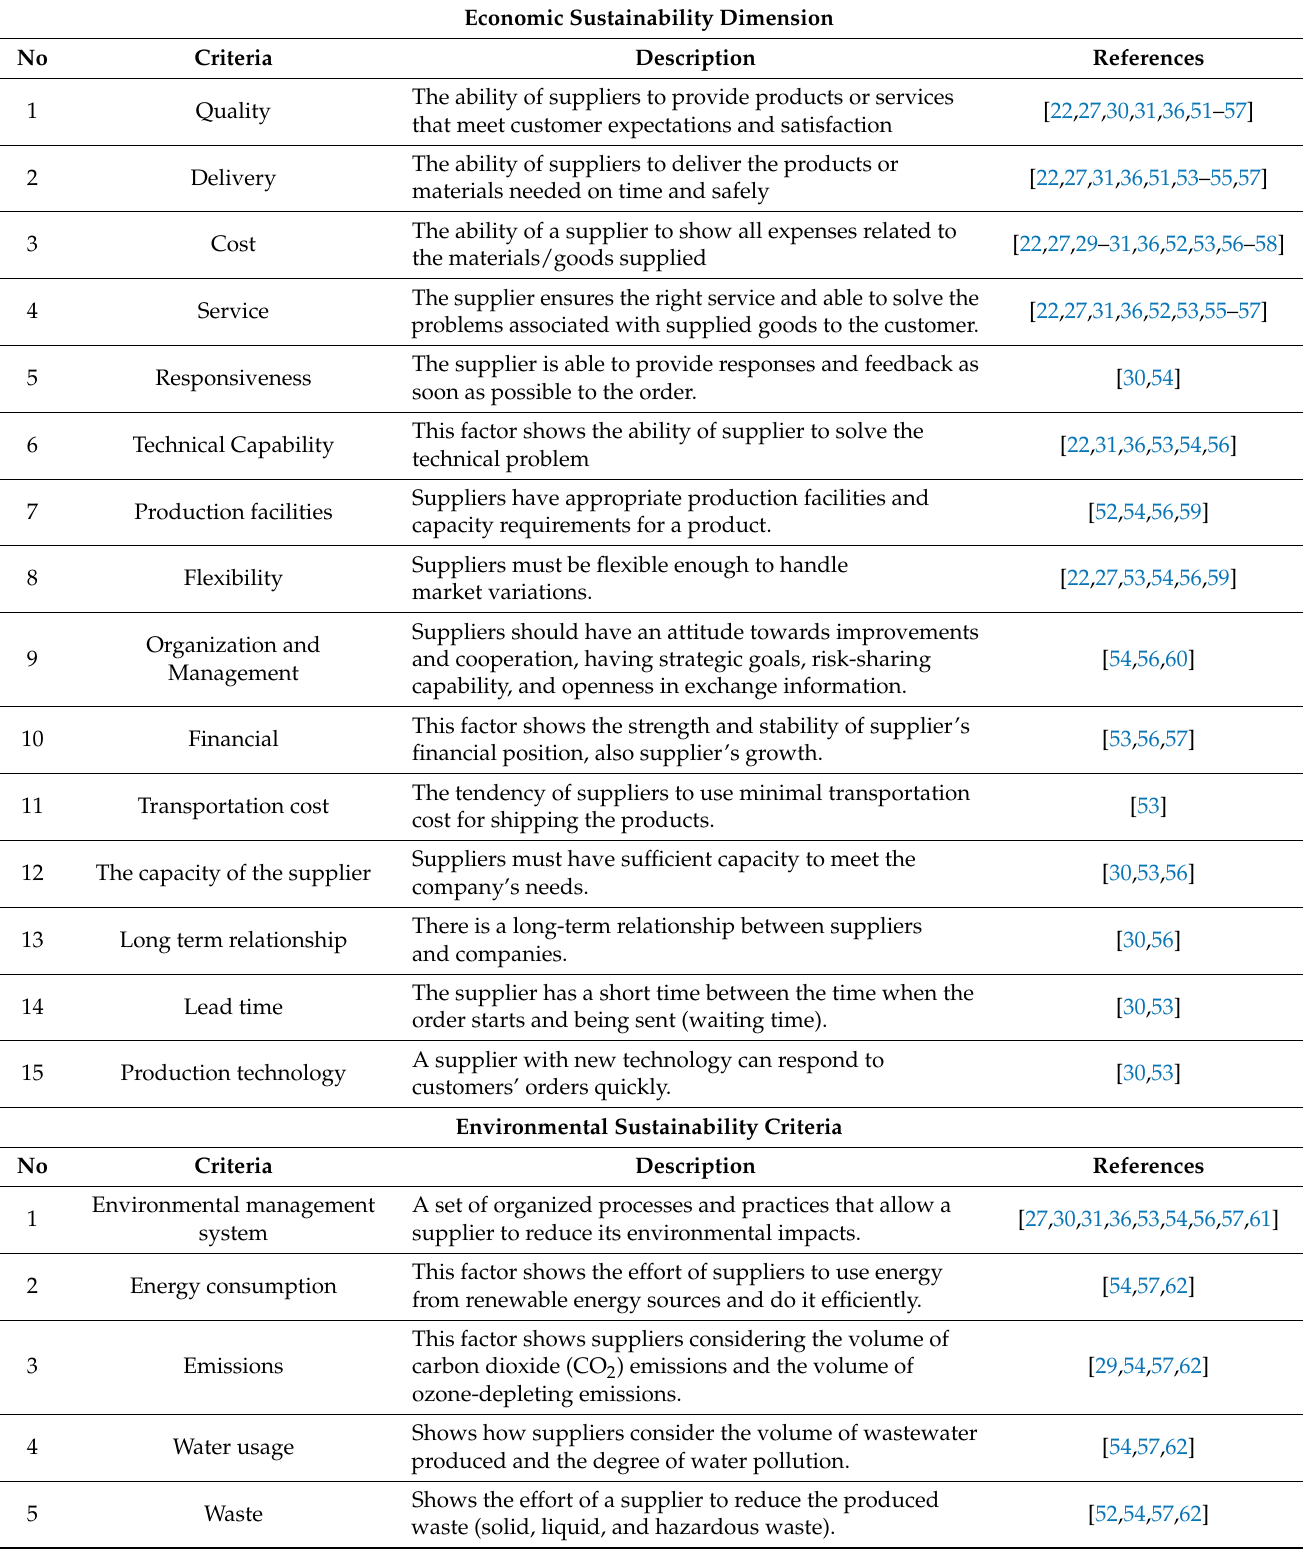
Table 1. Sustainability criteria for supplier